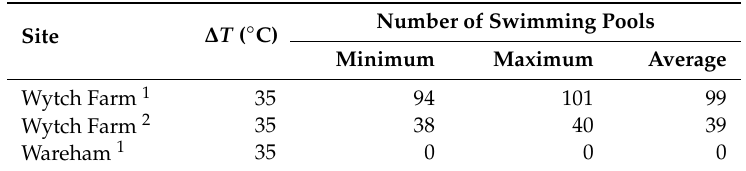
Table 7. Numbers of swimming